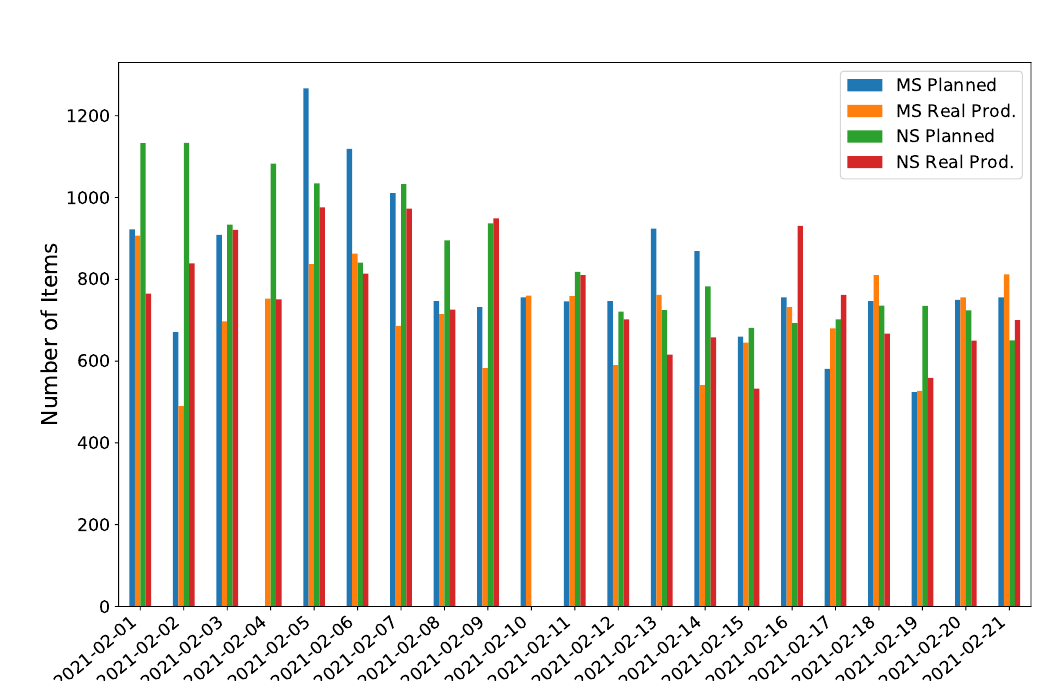
Figure 5. Variability between planned and delivered parts per shift: Morning (MS) and Night Shifts (NS) during Febru- ary